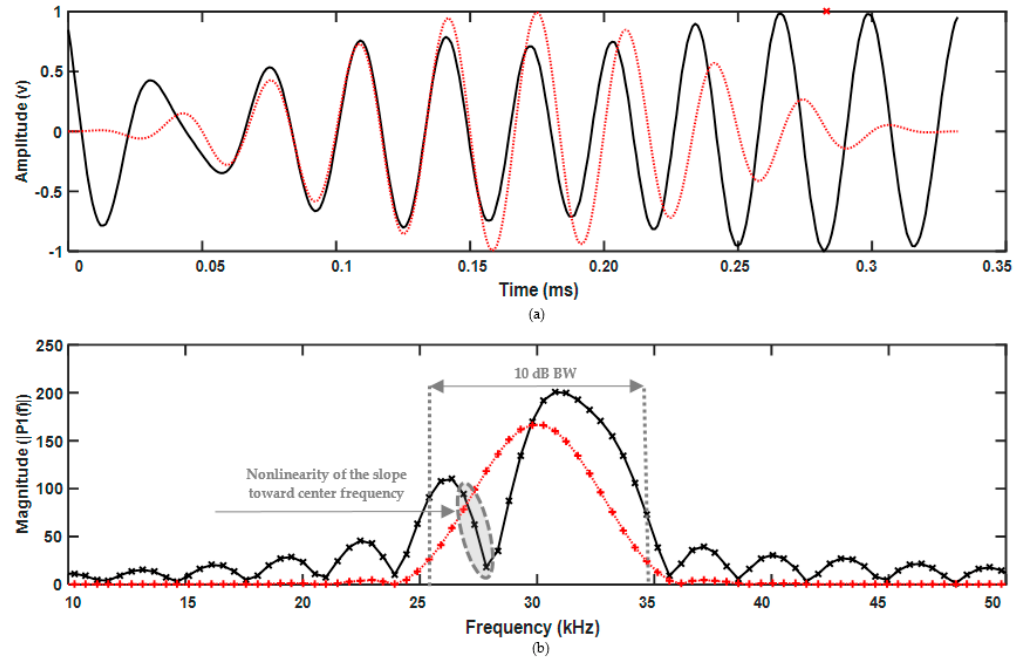
Figure 7. Example of an outlier case detected using Condition One (C1), where ( a ) shows the time domain of the iteration window and ( b ) is its respective power spectrum. The red lines show (dotted, +) the references achieved from excitation sequence and the black lines (solid, x) show the results from each iteration.